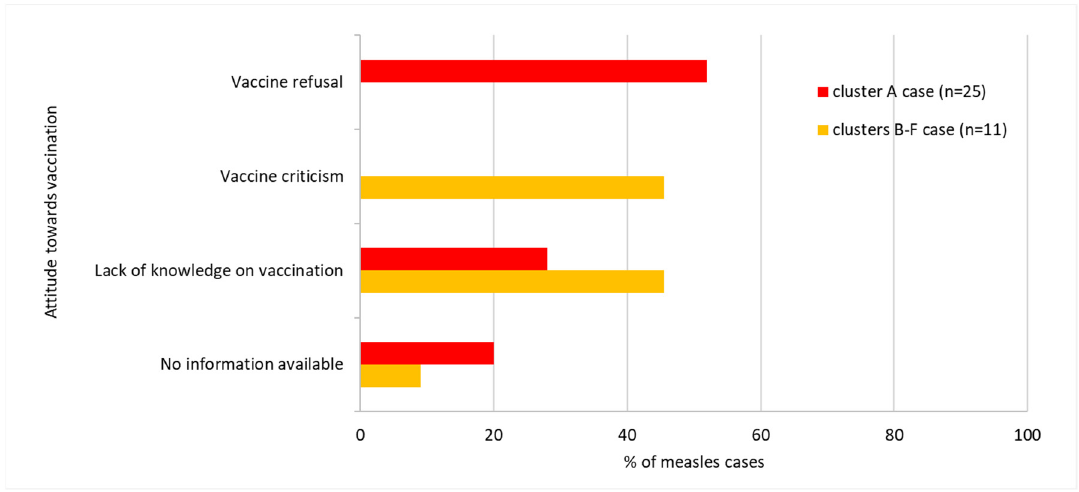
Figure 5. Measles cases according to attitude towards vaccinations and cluster, Austria, January–March 2019 (n = 36).